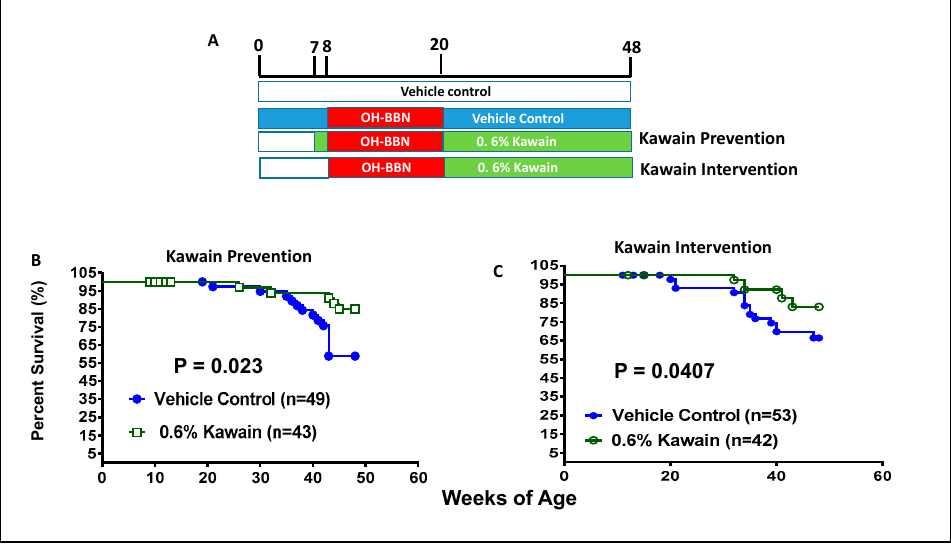
Figure 1. Dietary feeding of kawain inhibits OH-BBN-induced bladder carcinogenesis in mice. ( A ) A schematic presentation of experimental protocols for the anti-bladder carcinogenic effect of the kawain diet before and after OH-BBN exposures. ( B , C ) The survival curves of mice that were administrated with a control diet or with 0.6% kawain in the diet starting one week prior to OH-BBN administration or starting post-OH-BBN administration.